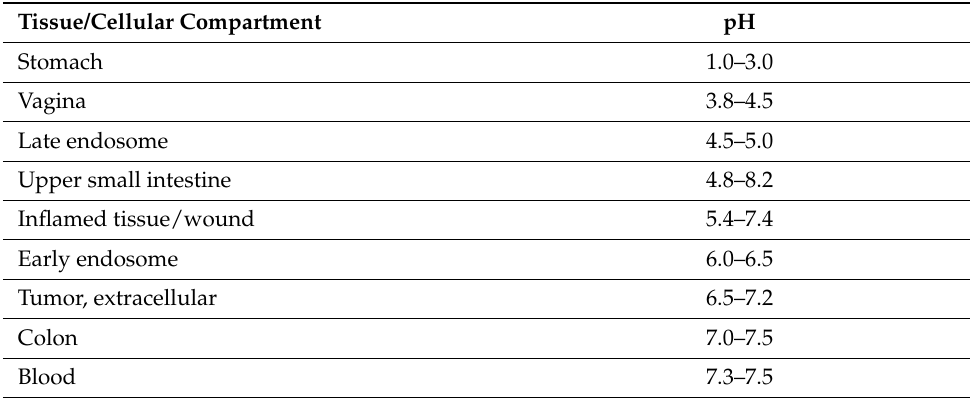
Table 1. pH in various tissues and cellular compartments